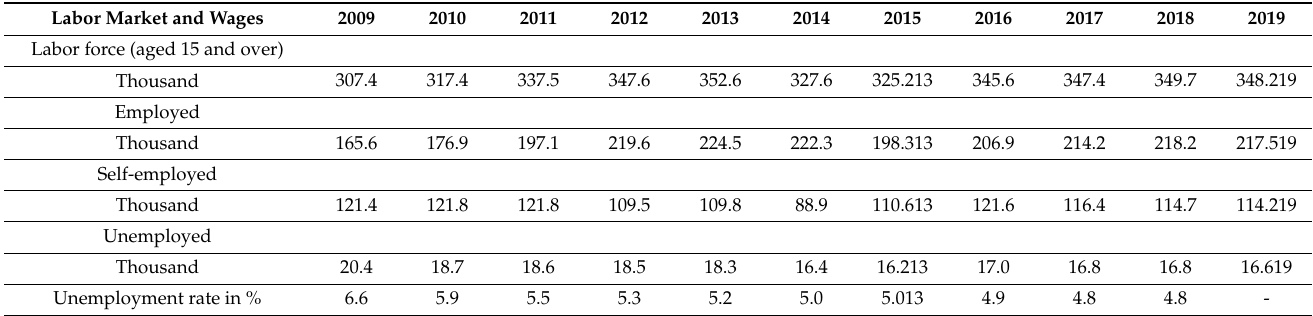
Table 3. Average per capita nominal monetary income of the population in the Aral district of Kyzylorda region, in tenge. Department of Statistics of Kyzylorda